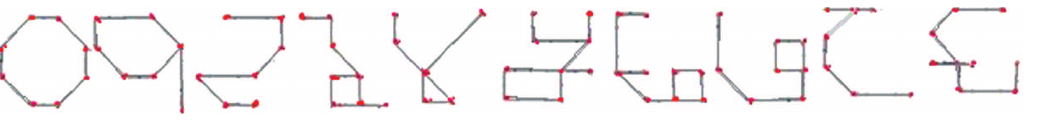
Figure 4: Snapshot of Underlying Graphs Obtained from Handwritten Devanagari Numerals with Interest Points (Numerals